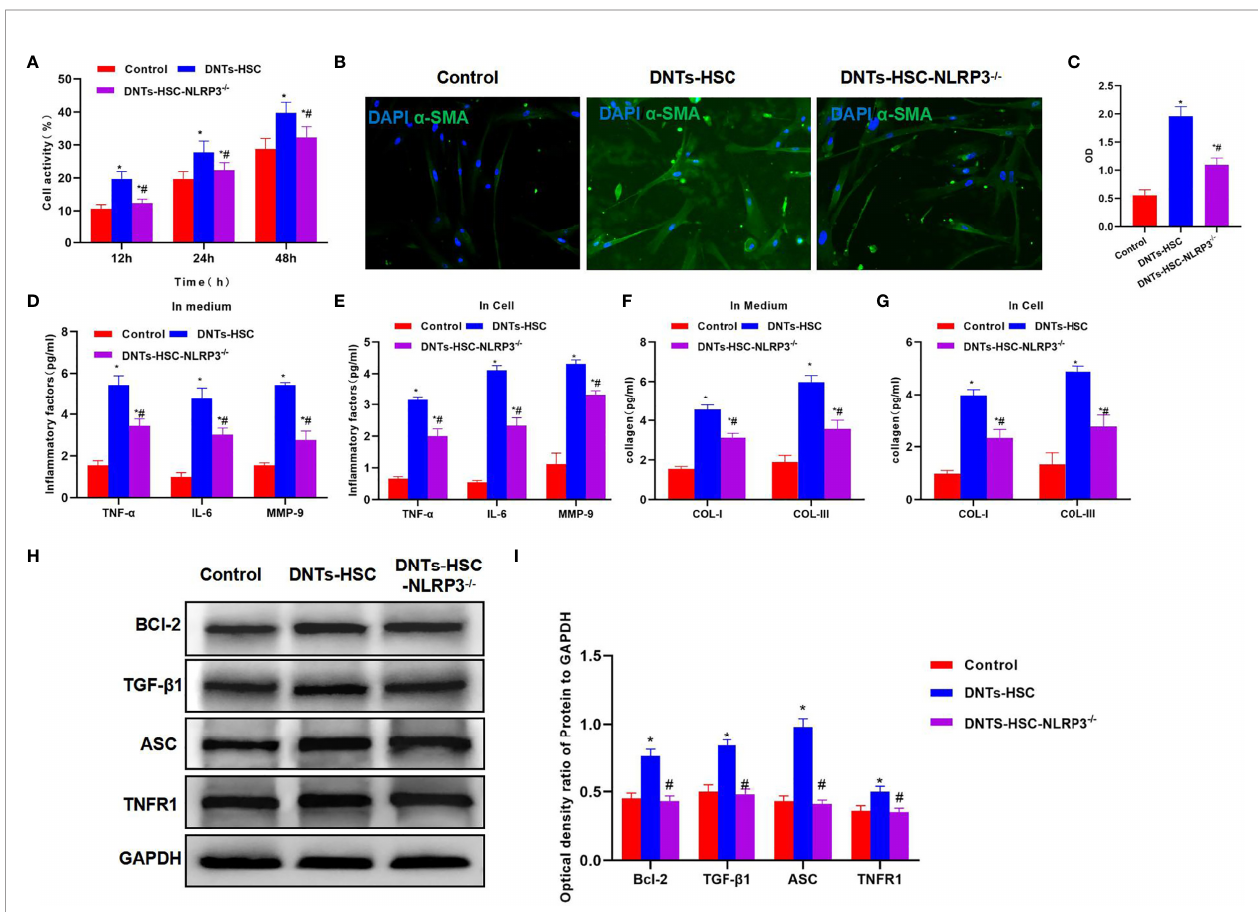
FIGURE 3 | Effect of DNTs on HSC activation after NLRP3 knockdown (HSC- NLRP3 − / − ). (A) After NLRP3 knockdown, DNTs had weakened ability to enhance HSC viability, which signi fi cantly decreased compared with HSC group, but were still higher than those in control group. *p < 0.05 compared with control group, # p < 0.05 compared with DNT-HSC group. (B, C) After NLRP3 knockdown, the fl uorescence intensity of HSC activation marker a -SMA signi fi cantly decreased, and the difference was signi fi cant as compared with HSC group. *p < 0.05 compared with control group, # p < 0.05 compared with DNT-HSC group. (D, E) As revealed by in fl ammatory factor expression results, the in fl ammatory factor levels in HSC- NLRP3 − / − group signi fi cantly decreased, lower than those in DNT-HSC group. Similar results were obtained for secreted in fl ammatory factors. *p < 0.05 compared with control group, # p < 0.05 compared with DNT-HSC group. (F, G) After NLRP3 knockdown, DNTs had decreased ability to induce collagen expression in HSCs. The levels of COL-I and COL-III signi fi cantly decreased in HSC- NLRP3 − / − , lower than those in DNT-HSC. *p < 0.05 compared with control group, # p < 0.05 compared with DNT-HSC group. (H, I) After NLRP3 knockdown, DNTs had reduced ability to induce TNFR1 and Bcl-2 expression, and the protein levels were evidently lower than those of DNT-HSC group. *p < 0.05 compared with control group, # p < 0.05 compared with DNT-HSC group. DNTs, double-negative T cells; HSC, hepatic stellate